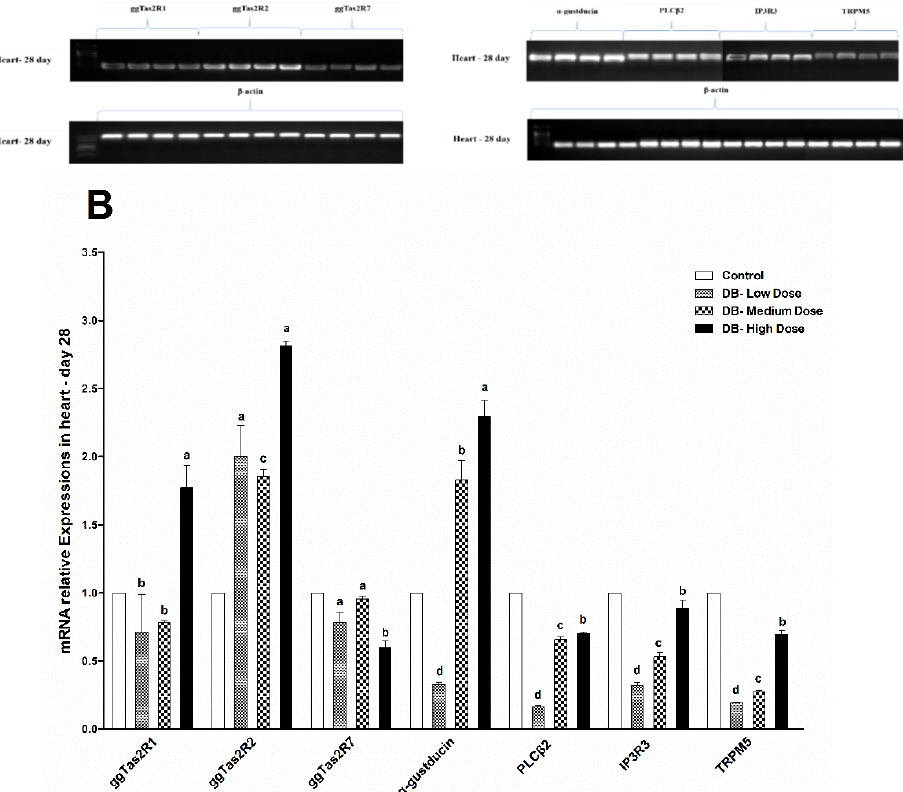
Figure 5. RT and qRT-PCR showed effects of DB supplementation on heart mRNA expressions of bitter taste receptors and downstream effectors at 07 days ( A ) and 28 days ( B ) of age. Data are presented as mean value ± SEM (n = 6). Values without the same mark (a–d) represent statistically significant differences ( p < 0.05). gg, Gallus gallus; PLC β 2, phospholipase C β 2; IP3R3, type 3 inositol-1,4,5-trisphosphate receptor; Denatonium benzoate- Low Dose treated group, Denatonium benzoate- Medium Dose treated group, Denatonium benzoate- High dose treated group.